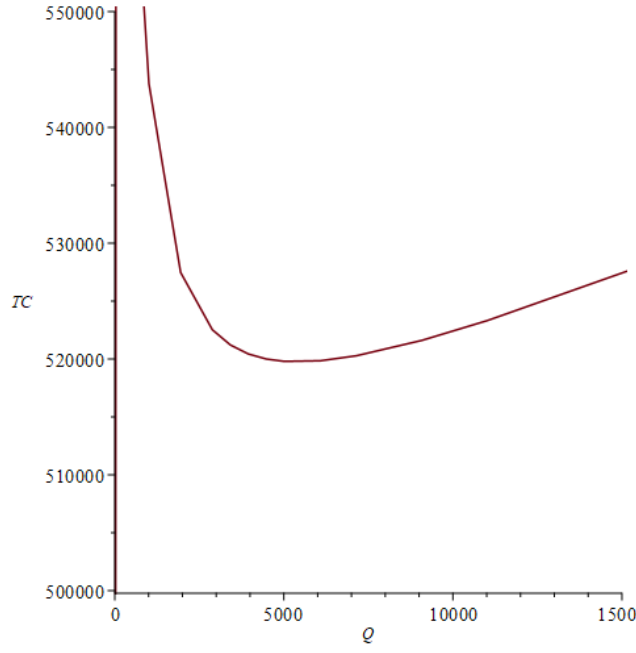
Figure 4. Relationship between Q and T c .